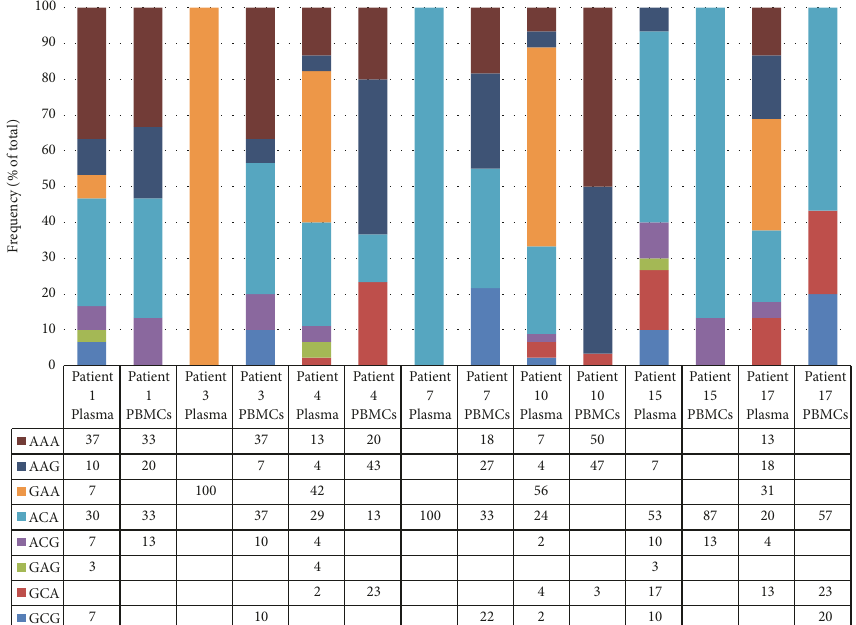
Figure 3: Distribution of nucleotide combinations at positions 107, 204, and 243 in PBMC- and plasma-derived IRES samples in different patients. Data represent the frequencies in percent of all possible nucleotide combinations at positions 107, 204, and 243 detected in PBMC- and plasma-derived HCV IRES samples from different patients.